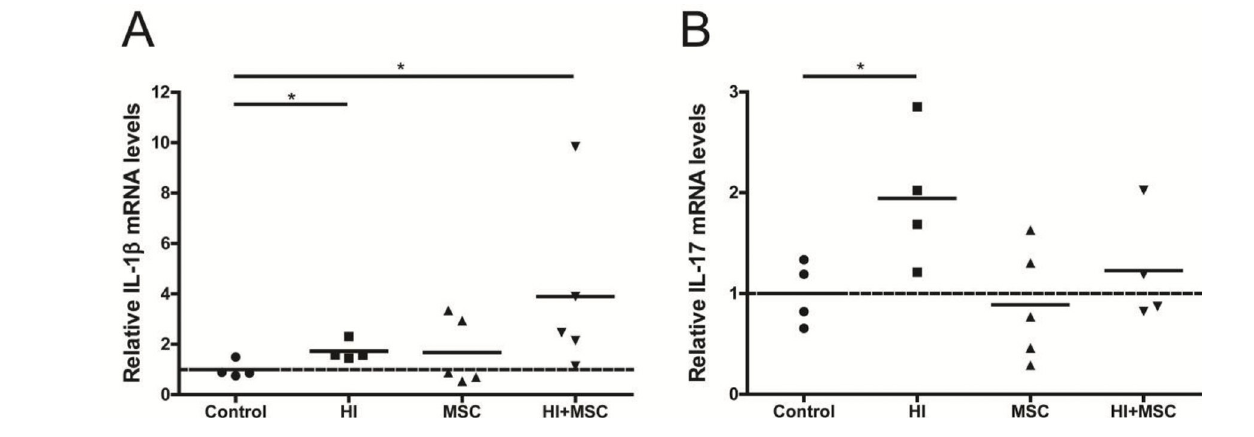
figure 4. Increased mRNA levels of inflammatory cytokines in the fetal intestinal tissue 7 d after global HI. The inflammatory cytokines (A) IL-1 b and (B) IL-17 were assessed by quantitative real-time PCR. * p <